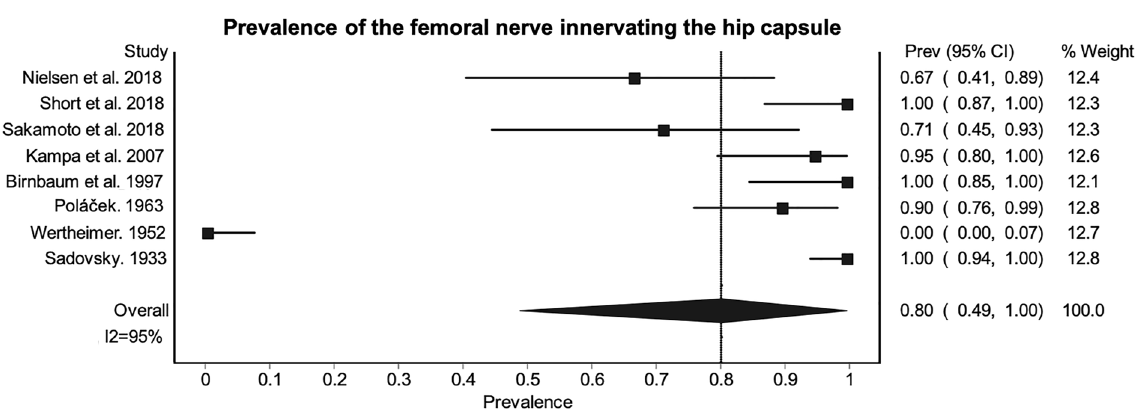
Figure 3. Prevalence of the femoral nerve innervating the hip capsule. Results indicate the variation in prevalence across studies, as well as the high heterogeneity as shown by the I 2 statistic of